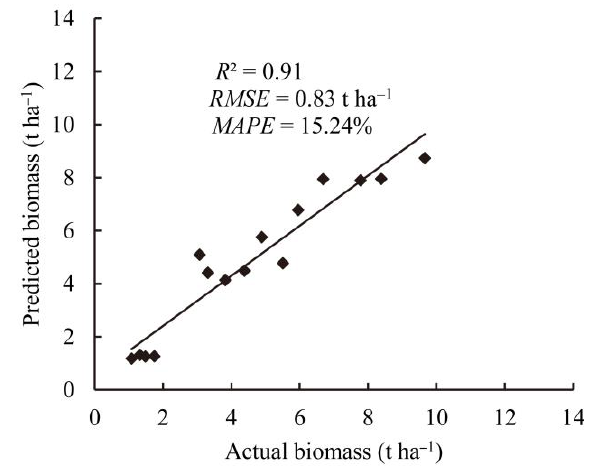
Figure 7. Validation results for the model developed by combining the spectral and textural information.